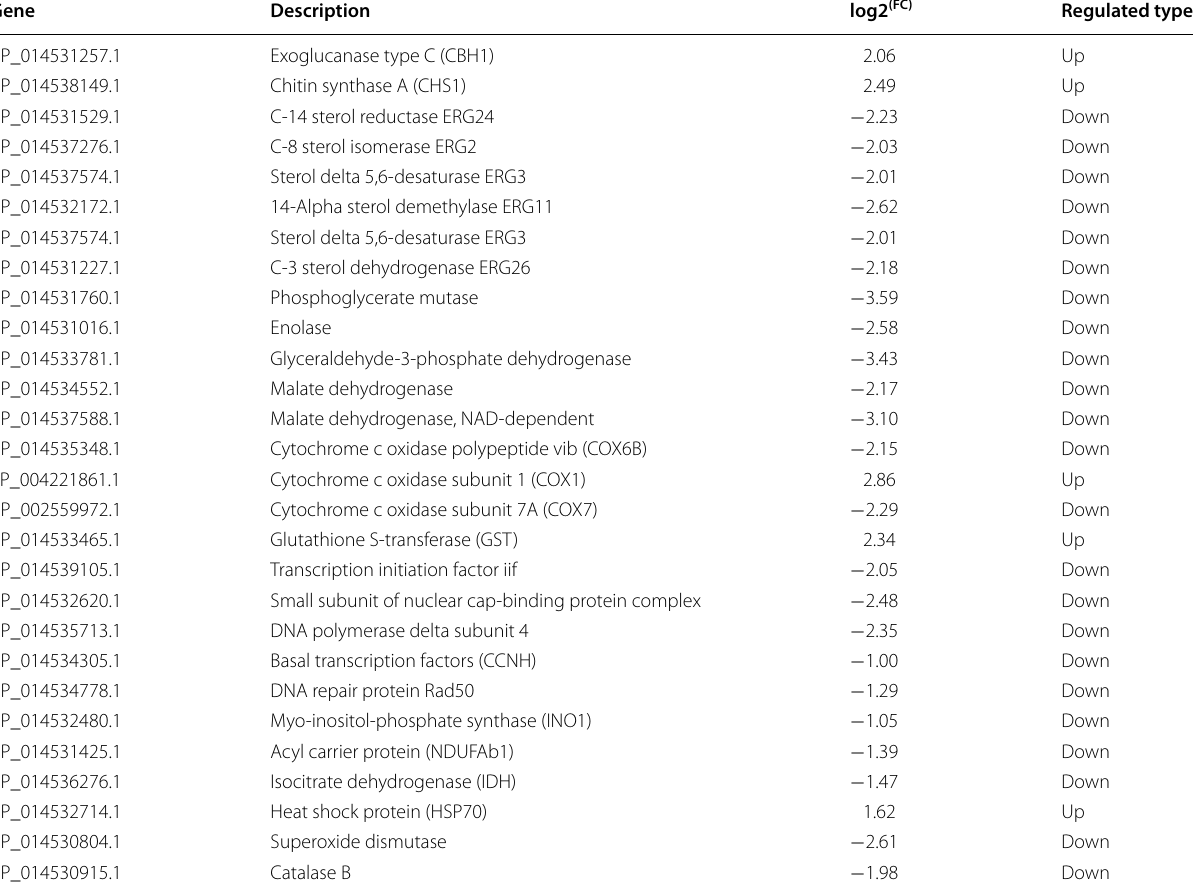
Table 2 Identification of differentially expressed genes in P. digitatum after X33 AMP treatment